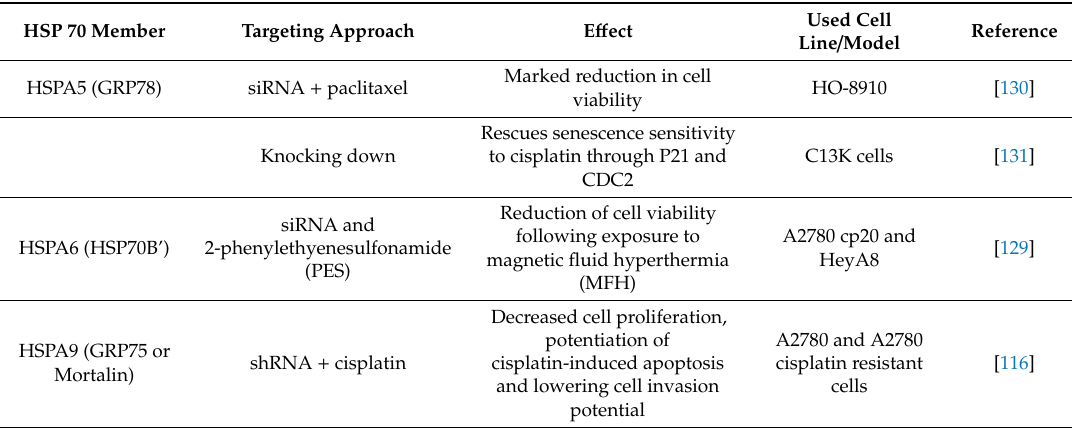
Table 3. Summary of pre-clinical studies targeting HSP70 members in